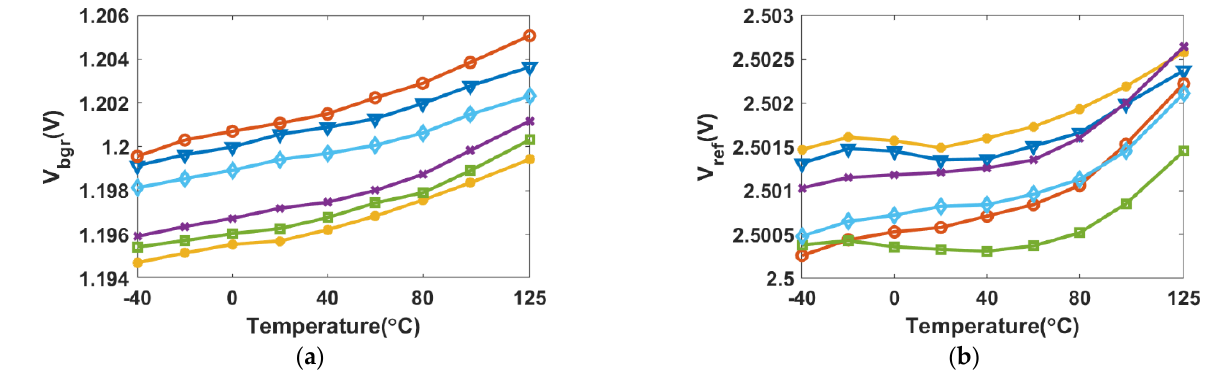
Figure 11. Measured TCs of six samples: ( a ) untrimmed V bgr as a function of temperature; ( b ) trimmed V ref as a function of temperature.